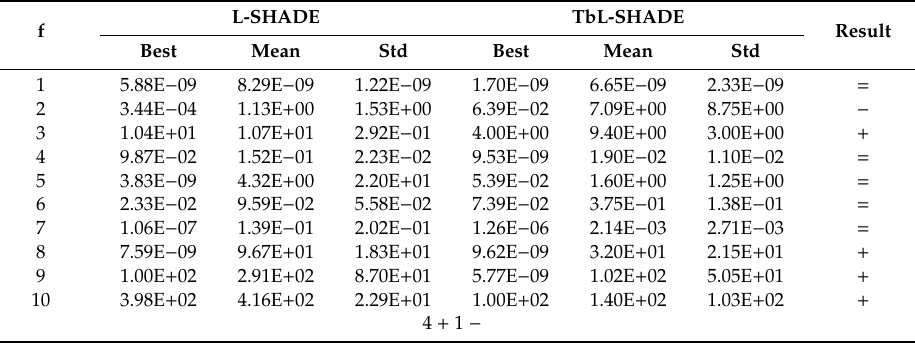
Table 12. L-SHADE vs. TbL-SHADE on CEC2020 in 10 D